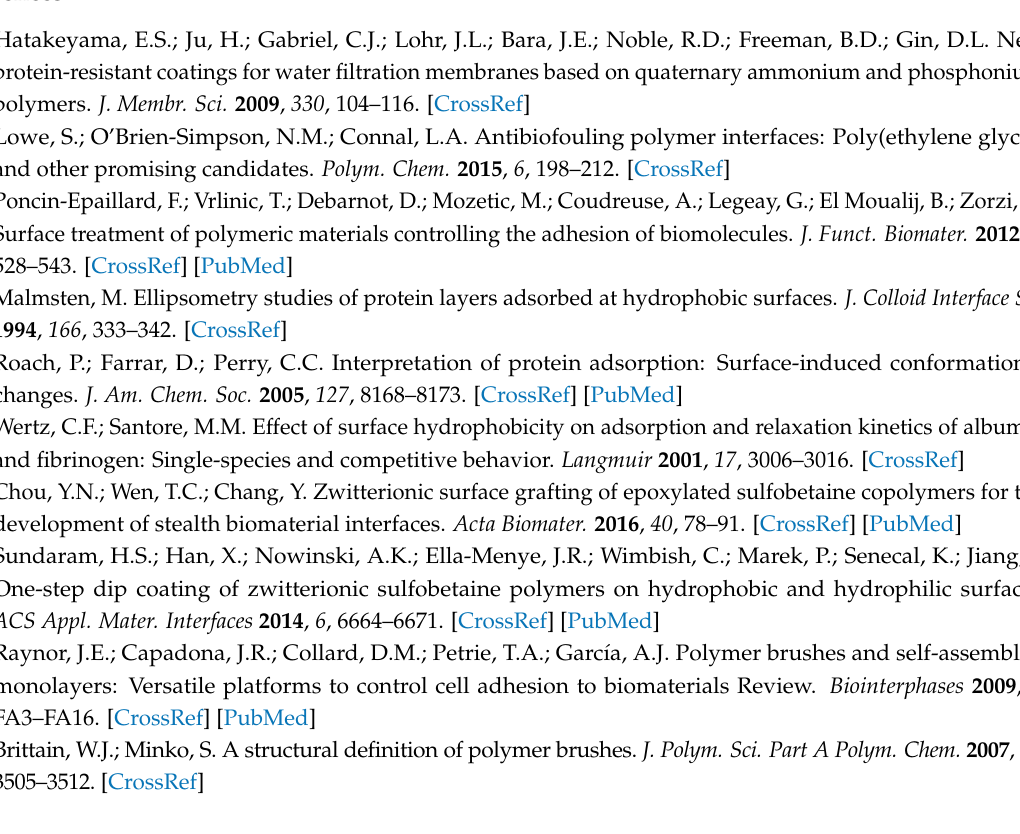
Figure S1: AFM tapping mode images; Table S1: Roughness recorded for one sample of each